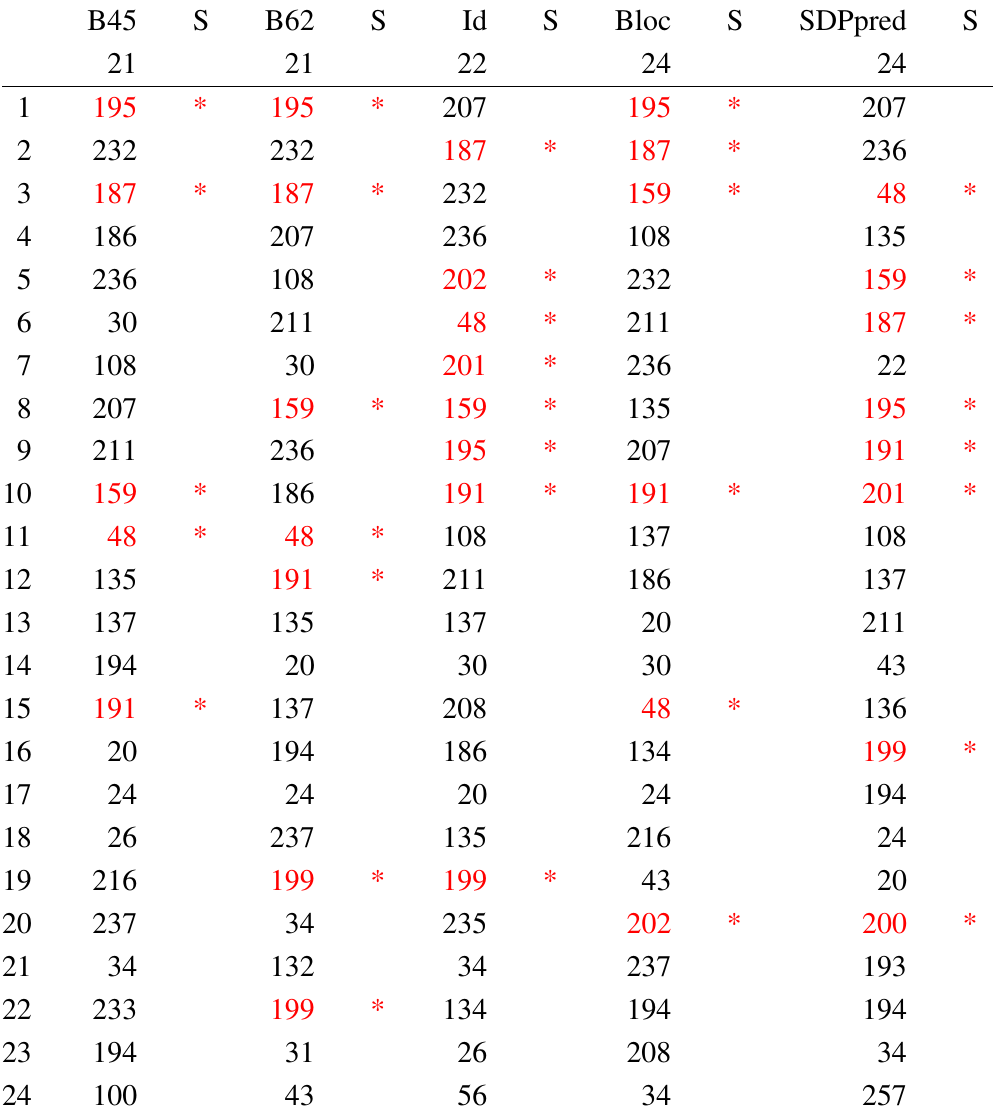
Table 1. SDPs inferred from 60 members of the MIP family. The Table shows the 24 best ranking SDPs responsible for the distinction between aquaporins and the glycerol-uptake facilitators within MIPs. ( ∗ ) indicate a significant position according to the measure for functional significance used by Kalinina et al. [2] (see text for details). The corresponding positions are also colored in red to facilitate the table reading. Results from BLOSUM45 (B45), BLOSUM62 (B62), Identity (Id) and the local BLOSUM (Bloc) substitution matrices are also reported for comparison. Residue numbering refers to GlpF protein from E. Coli . In the second row the number of positions reckoned to be significant by the various runs are